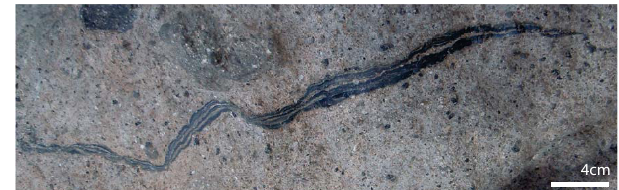
Fig. 1. Field photo of the shear band. In the shear band up to seven interlayered bands of aphanitic pseudotachylyte and cataclasite lay- ers and lenses are observed. The photograph illustrates the lateral variation in thickness and its morphology, which suggests forma- tion in viscous magma in the conduit.